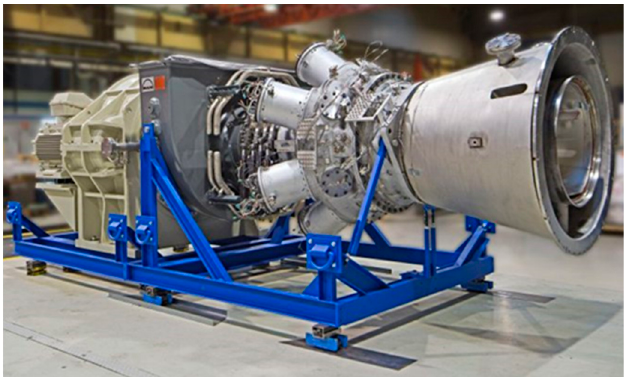
Figure 1. Gas turbine MGT6000 (MAN Energy Solutions SE, Oberhausen, Germany).